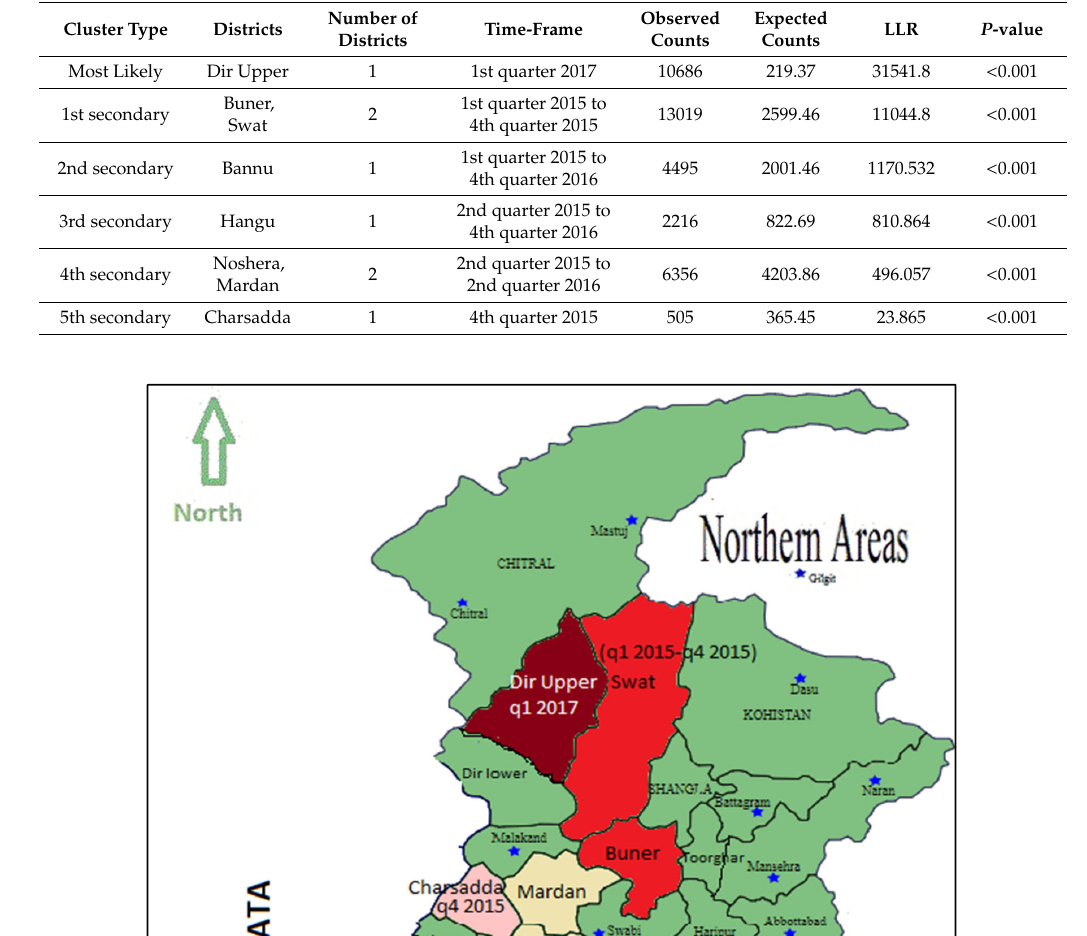
Table 1. The detected space-time clusters of TB cases in Khyber Pakhtunkhwa, Pakistan.